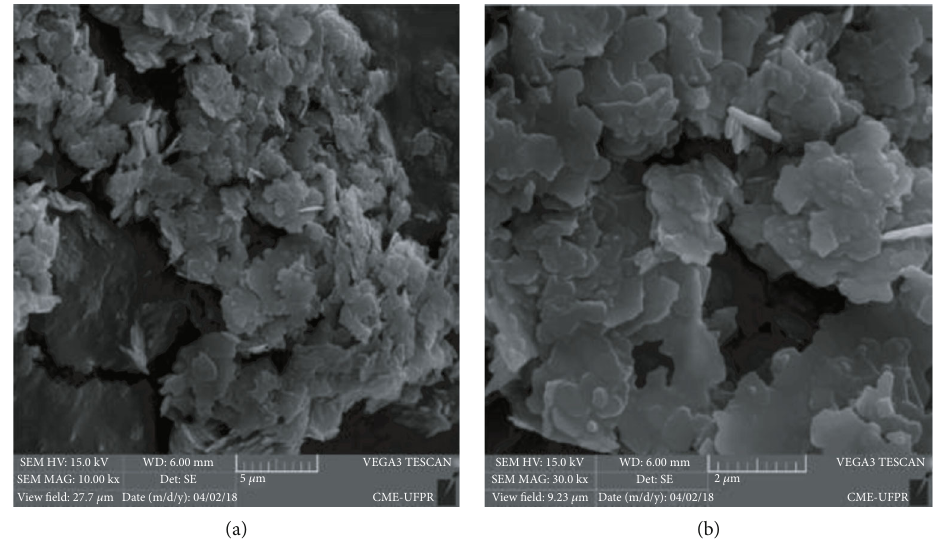
Figure 1: SEM images of (a) NO